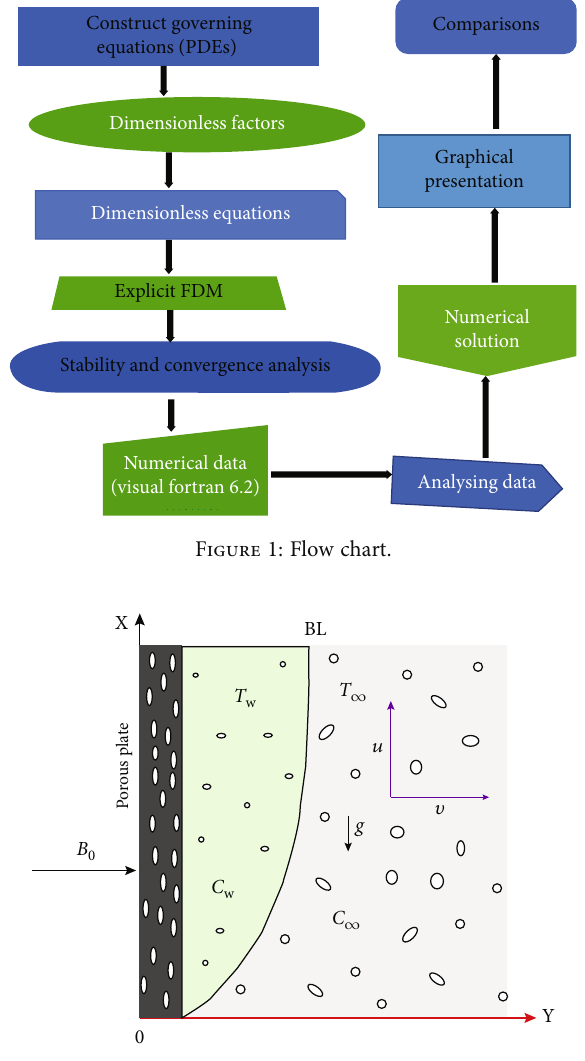
Figure 2: Physical con fi guration and coordinate